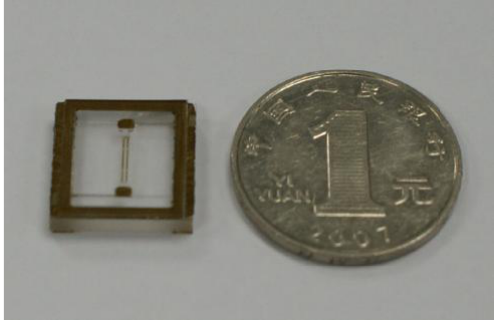
Figure 4. Image of the fabricated all-quartz pressure sensing